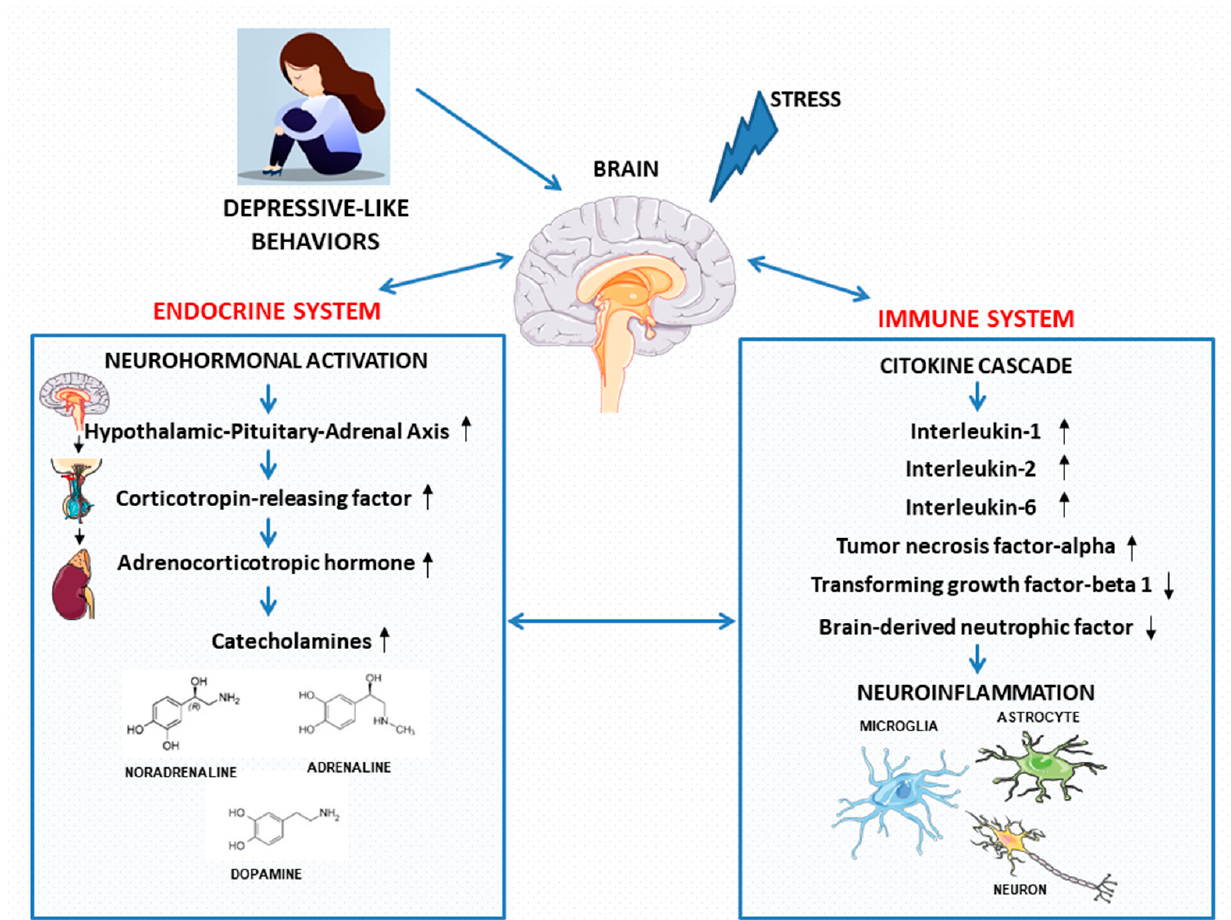
Figure 3. Immune mechanisms and biological molecules involved in the depressive-like behaviors. The figure was drawn using the vector image bank of Servier Medical Art by Servier (available at http://smart.servier.com/, accessed on 21